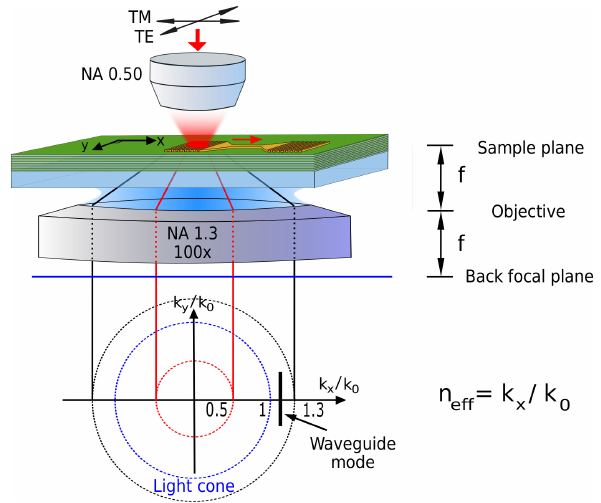
Figure 2. The scheme of a leakage radiation microscopy experiment with a schematical intensity map of a back focal plane image. The Bloch surface wave (BSW) modes appear as sharp narrow vertical